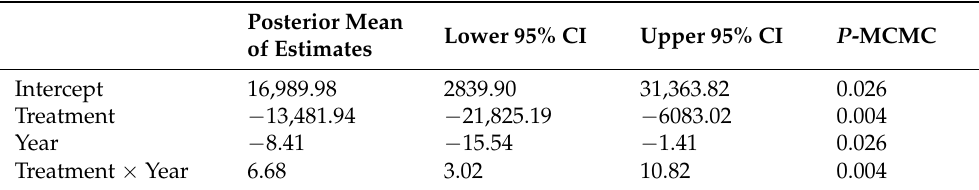
Table 2. Results of the generalized linear mixed model based on Markov chain Monte Carlo tech- niques (MCMC-GLMM).